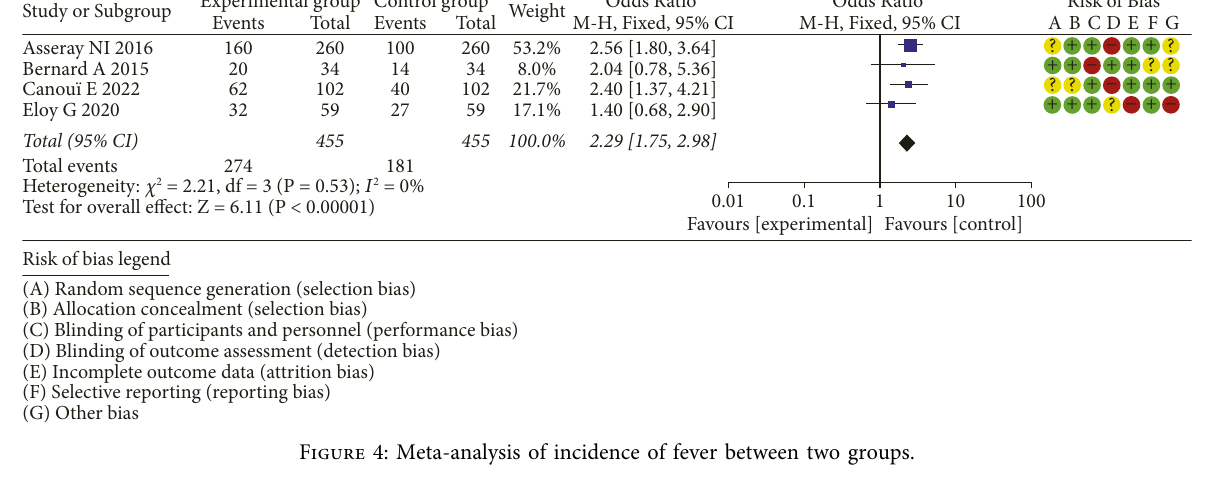
Figure 4: Meta-analysis of incidence of fever between two groups.